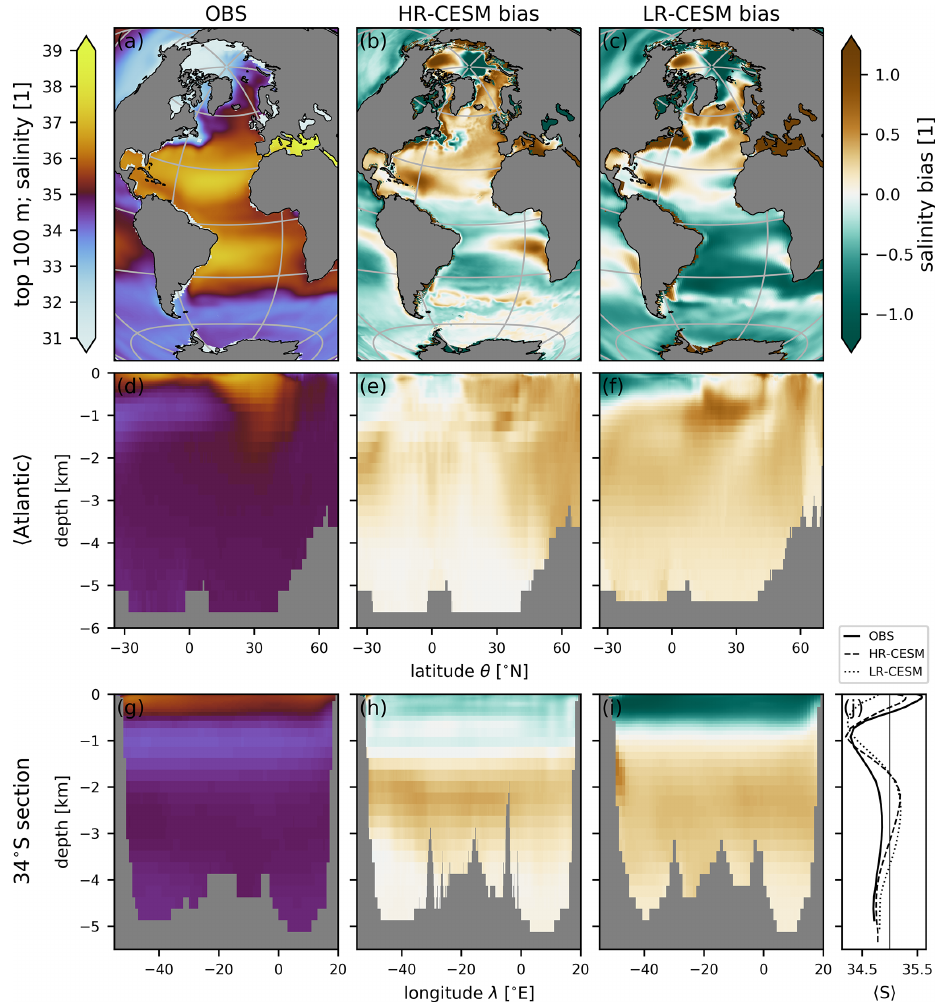
Figure 3. The salinity distribution in the EN4 observations (a, d, g) and the bias of the HR-CESM (b, e, h) and LR-CESM (c, f, i) CTRL simulations for the top 100m (a, b, c) , zonally averaged in the Atlantic (d, e, f) , and at the 34 ◦ S transect (g, h, i) . Panel (j) shows zonally averaged salinity profiles for observations (thick solid line) and the HR-CESM (dashed) and LR-CESM (dotted) simulations together with the reference salinity S 0 = 35 (thin solid). Note that salinity as a mass fraction is